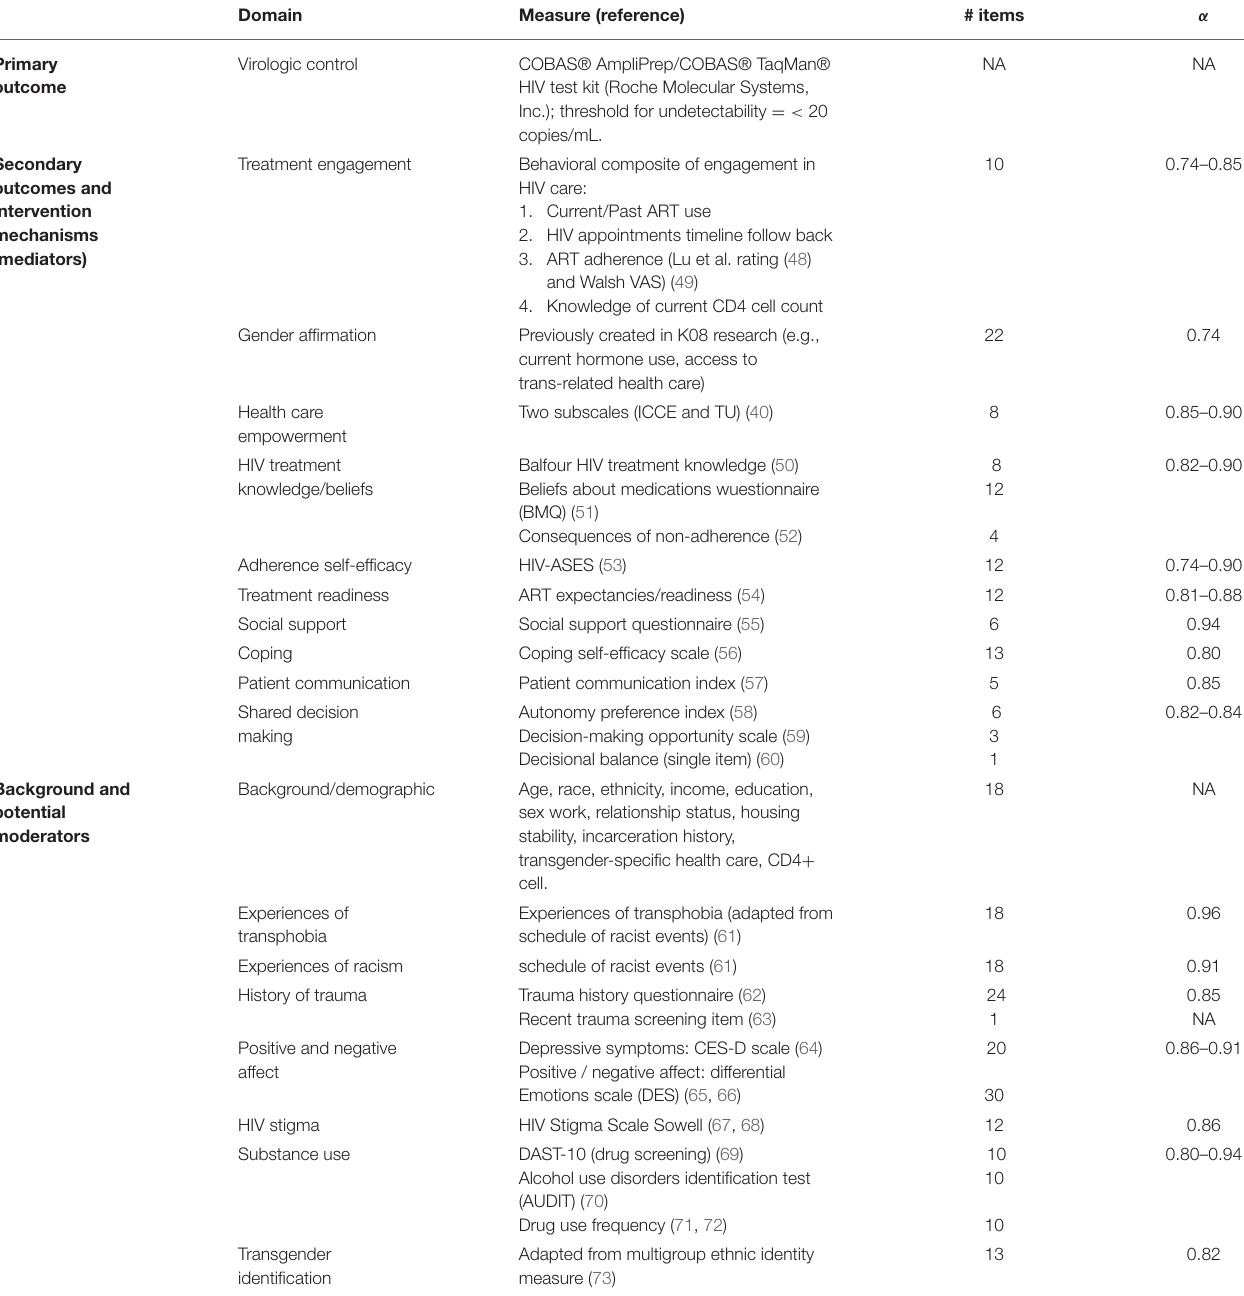
TABLE 2 | Outcomes and measures. Domain Measure